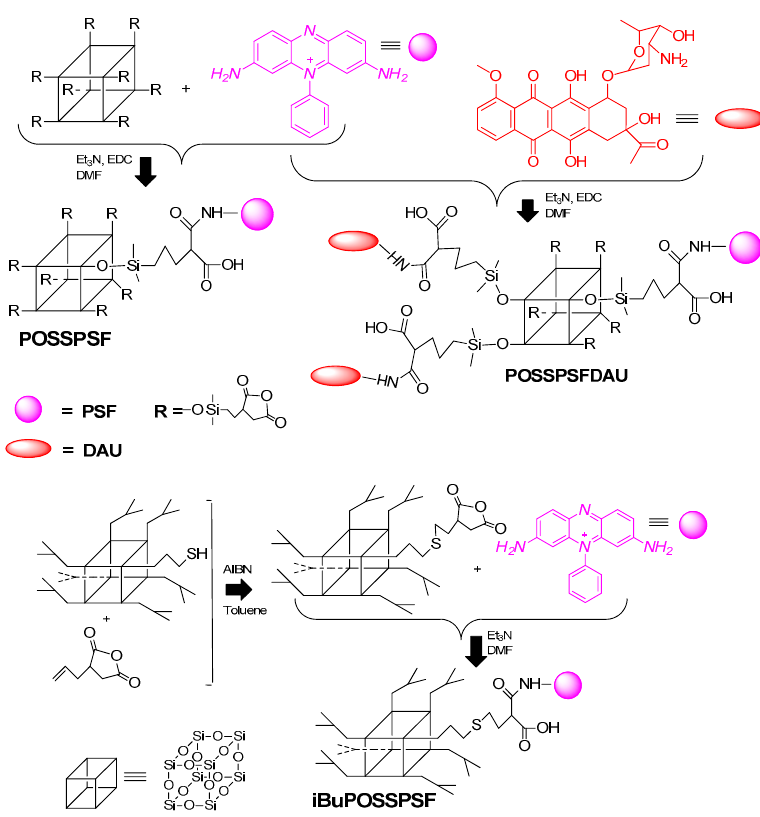
Figure 1. Synthetic route for POSSPSF, POSSPSFDAU and iBuPOSSPSF